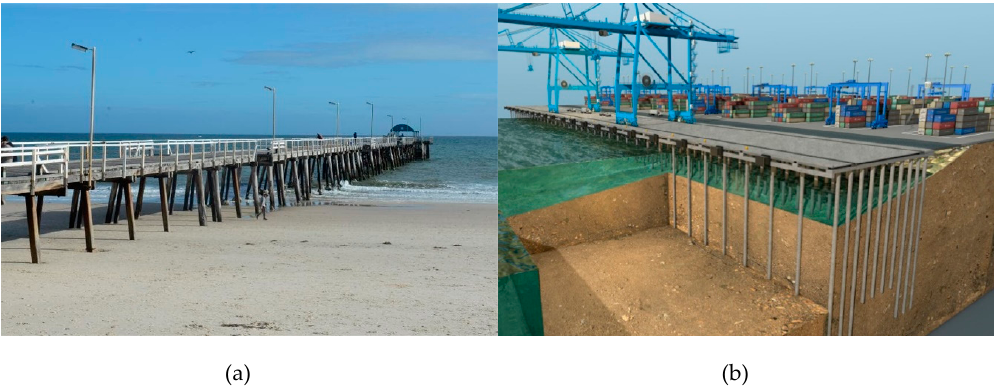
Figure 1. Pile supported structures: ( a ) a Henley beach jetty, South Australia and ( b ) a wharf [17].